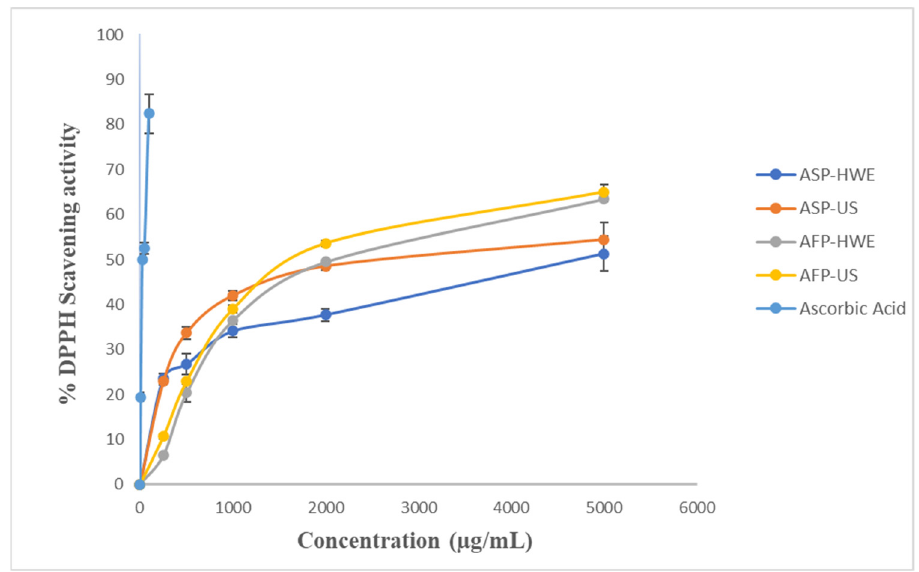
Figure 7. The DPPH scavenging ability of polysaccharides extracted from Ajwa seed and flesh. Results are presented as means ± standard deviations ( n = 3). Differences are statistically significant if p < 0.05 when compared to the control.